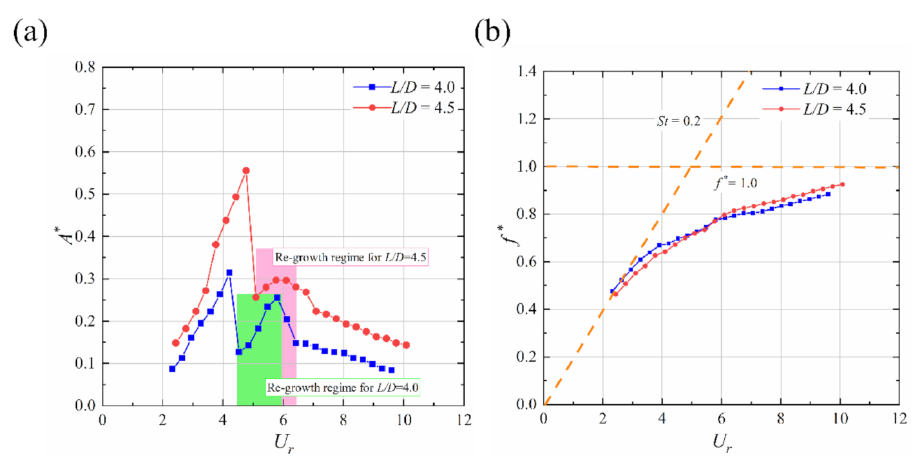
Figure 11. Complete rotation response of FIR system at L / D = 4.0 and 4.5: ( a ) Arc length response; ( b ) Frequency